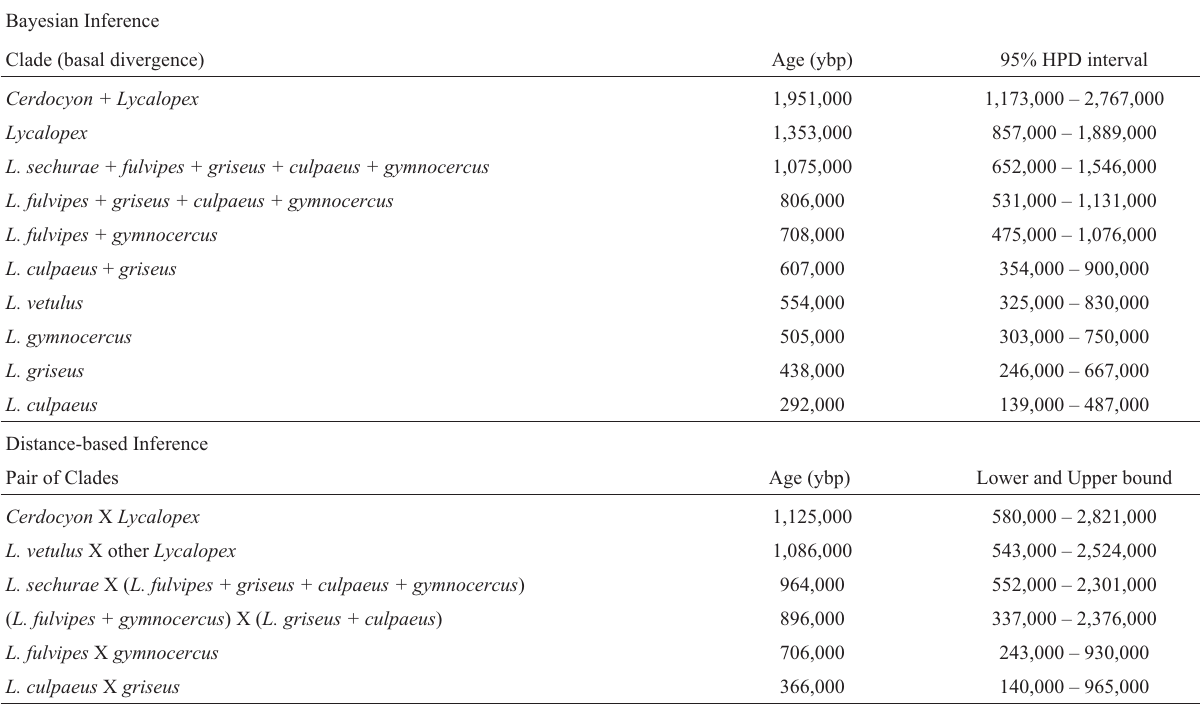
Table 2 - Divergence time estimated for Lycalopex groups with a Bayesian dating analysis and a distance-based approach (see text for details). Bayesian